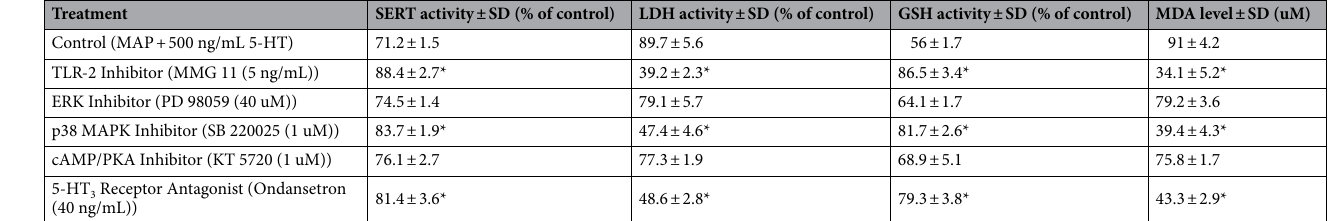
Table 3. Effects of several inhibitors involved in TLR-2 signaling pathway on the activities of SERT, LDH, GSH and MDA level in MAP-infected Caco-2 monolayers in the presence of excess level (500 ng/mL) of 5-HT following 24 h of incubation. Values were pre-tested for normal distribution using the Kolmogorov–Smirnov normality test. Significance among experiments was assessed by two-way analysis of variance (ANOVA) followed by Bonferroni correction test. All SERT, LDH, GSH, and MDA activity experiments were performed in triplicates. * P value <